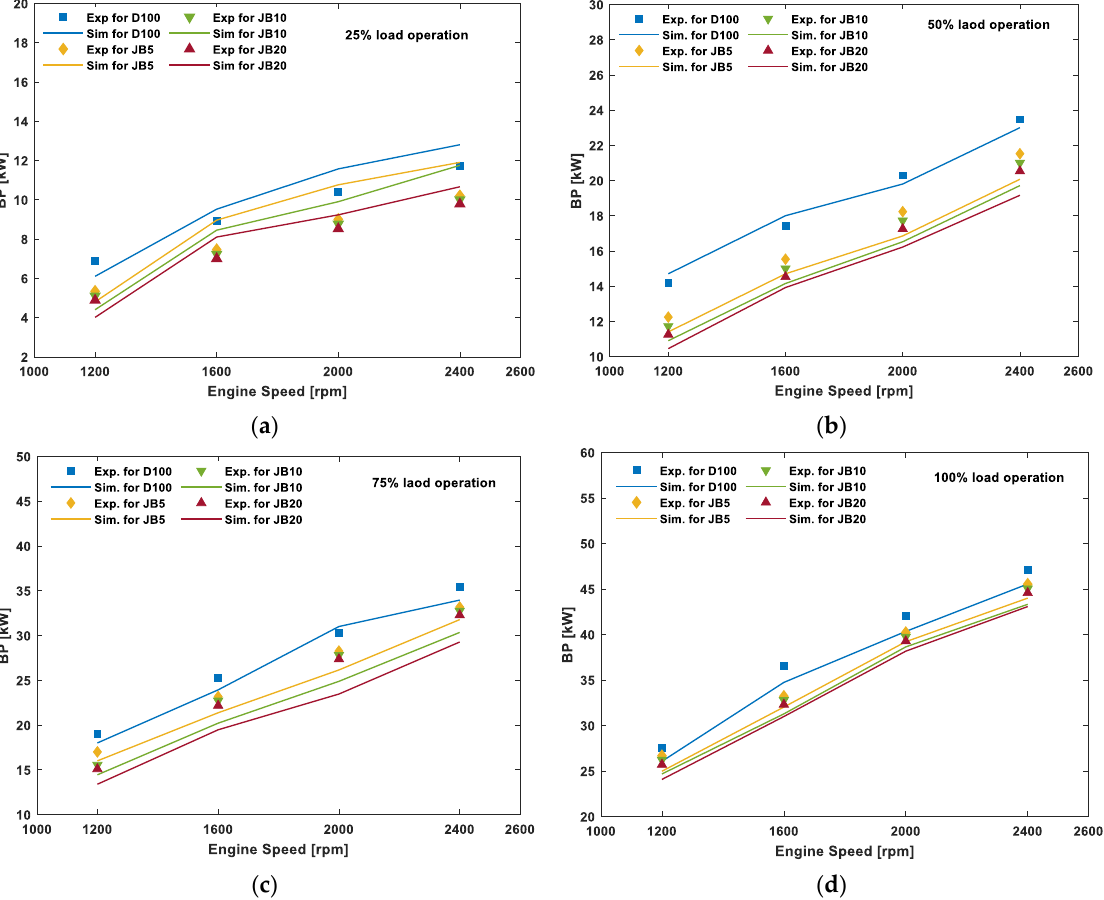
Figure 3. Comparison between simulation and experimental results of BP for diesel and JB blends